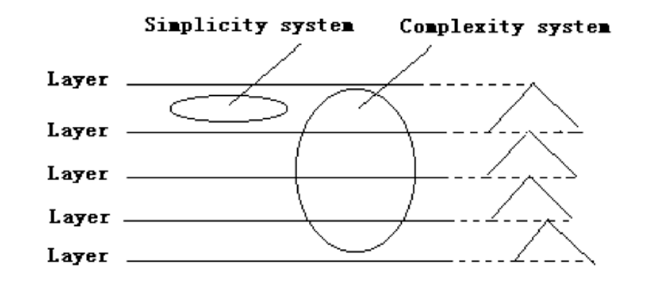
Figure 2. Simplicity system and the complexity system.